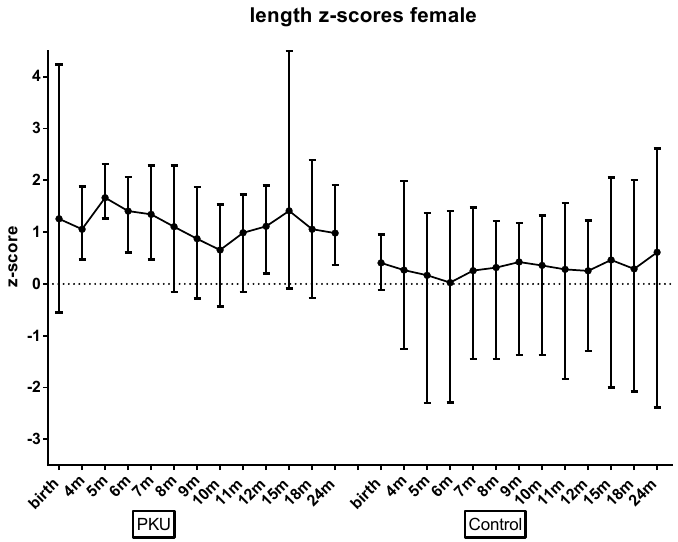
Figure 2. Mean male BMI z-scores for PKU vs. control groups by age.